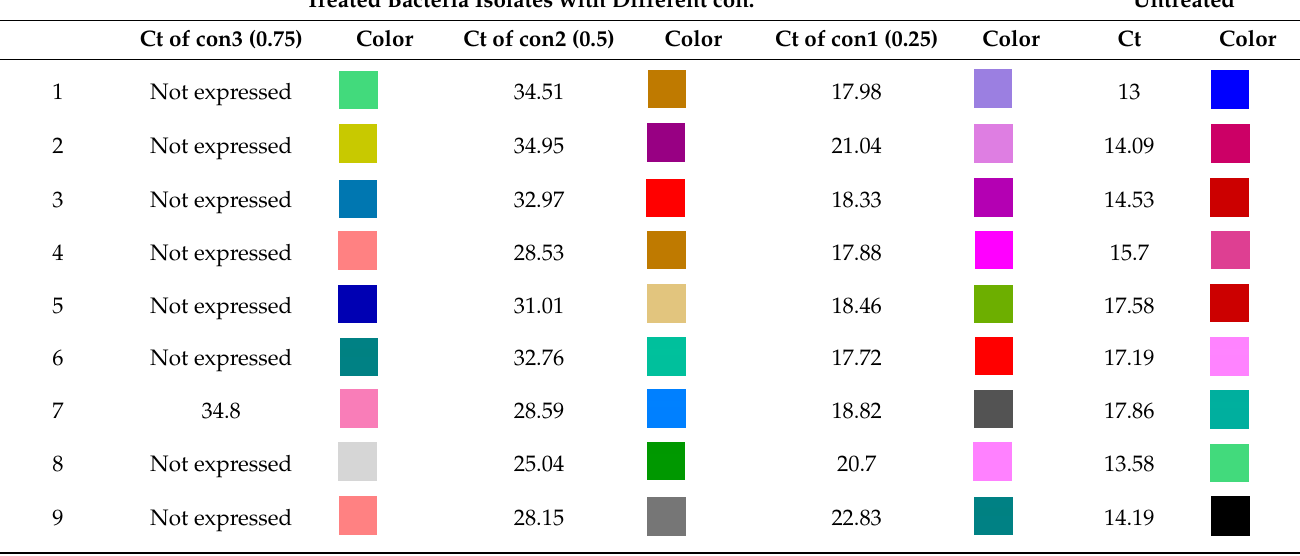
Table 3. k2A gene expression in Klebsiella pneumoniae isolates treated with different concentrations of ZnO NPs *. Treated Bacteria Isolates with Different con.